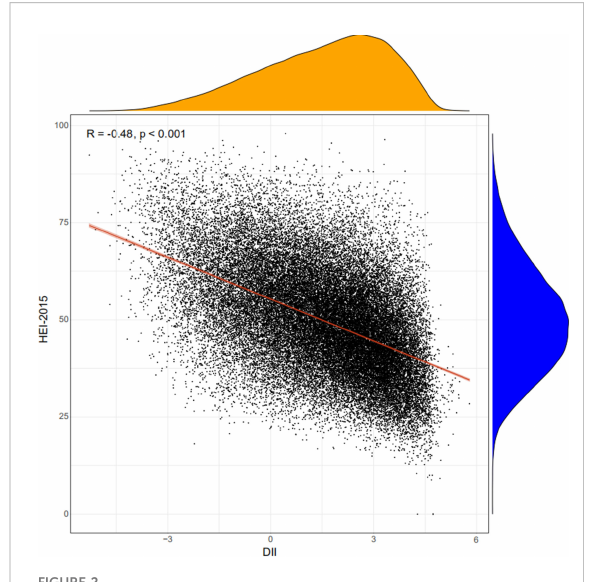
FIGURE 2 Correlation between DII and HEI. DII, Dietary In fl ammatory Index; HEI, Healthy Eating Index.